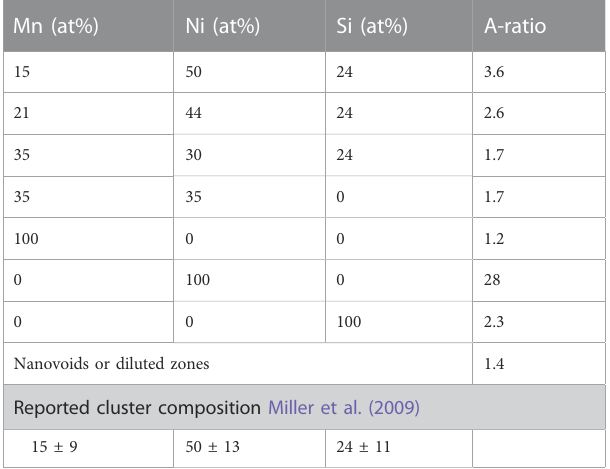
as compared to 1.14 wt% in the present study) may be responsible for a lower Mn content in the clusters and a correspondingly higher A-ratio without the need to refer to error bars. It can be concluded that the A-ratio measured for the irradiation-induced scatterers is consistent with the reported cluster composition of Mn-Ni-Si-rich